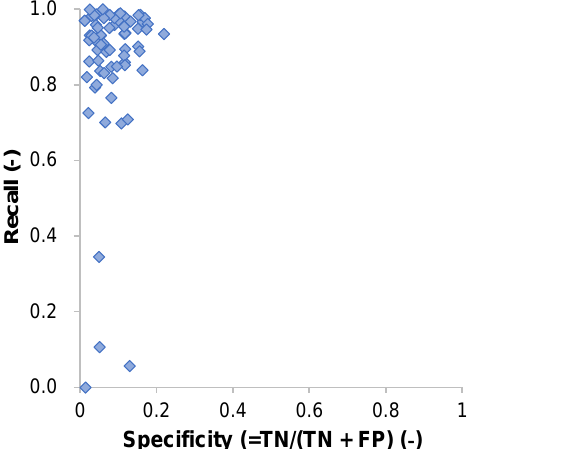
Figure 5. A receiver operating characteristic (ROC) of randomly selected test dataset.